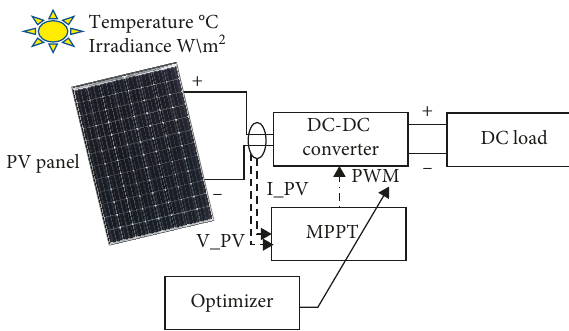
Figure 7: The proposed PV system with metaheuristic